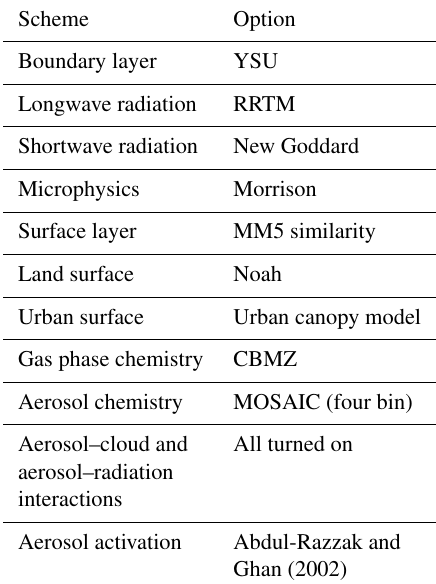
Table 1. Summary of major parameterization